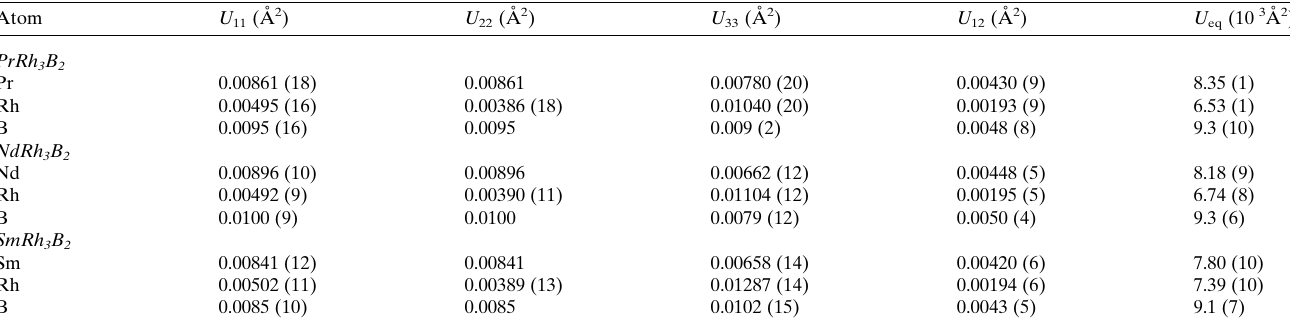
Table 2 Atomic displacement parameters of RE , Rh, and B atoms in RE Rh 3 B 2 ( RE = Pr, Nd, and Sm).